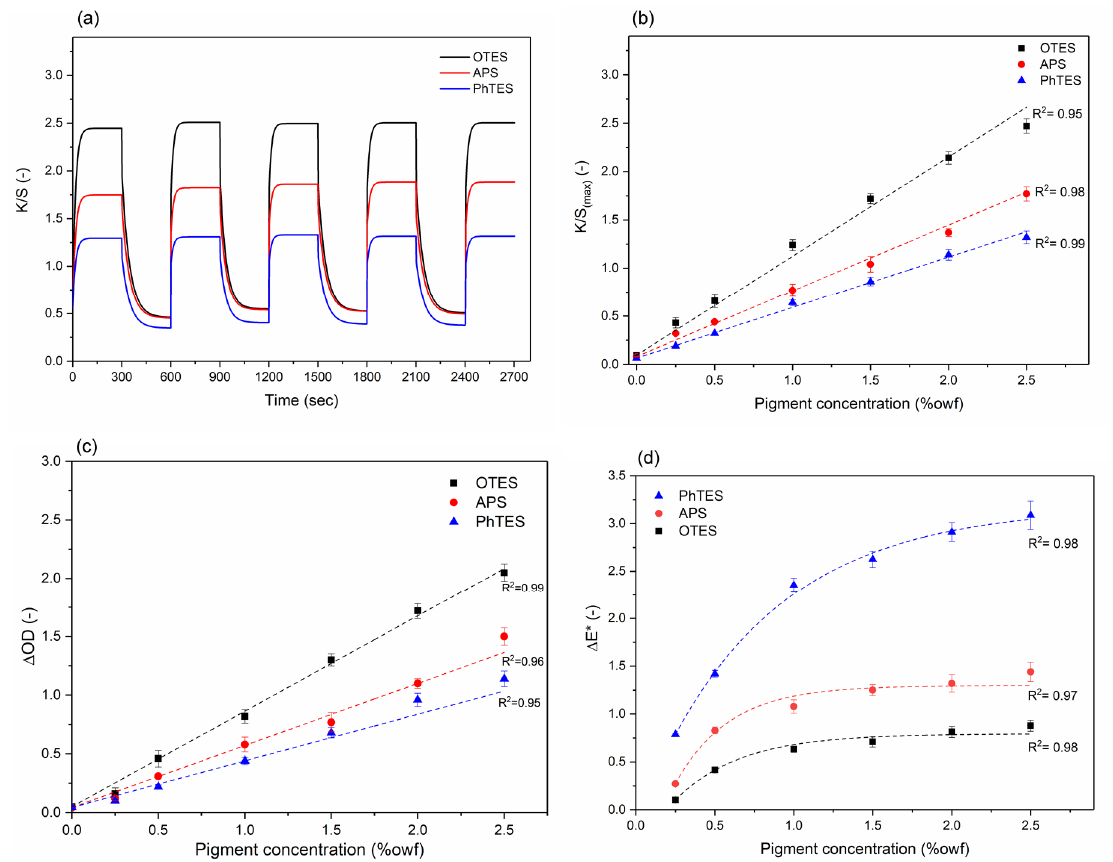
Figure 25. K / S values of PET fabric: ( a ) Photochromic pigment-2.50 wt.%; ( b ) K / S (max) ; ( c ) ∆ OD and Figure 25. K/S values of PET fabric: ( a ) Photochromic pigment-2.50 wt.%; ( b ) K/S (max); ( c ) ΔOD and ( d ) ( d ) ∆ E* values (Applied permission from [170], with kind permission of Taylor and ΔE* values (Applied permission from [170], with kind permission of Taylor and Francis).